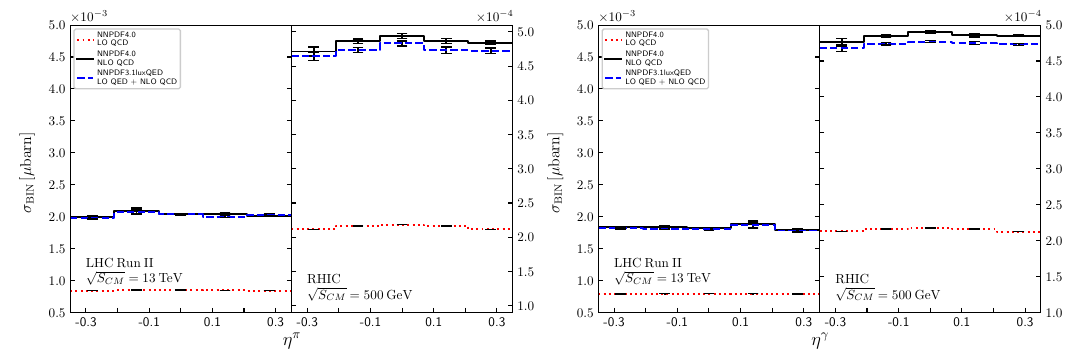
Figure 2: Same as Fig. 1, but now as a function of the rapidity of the pion (left) and the photon (right), respectively.